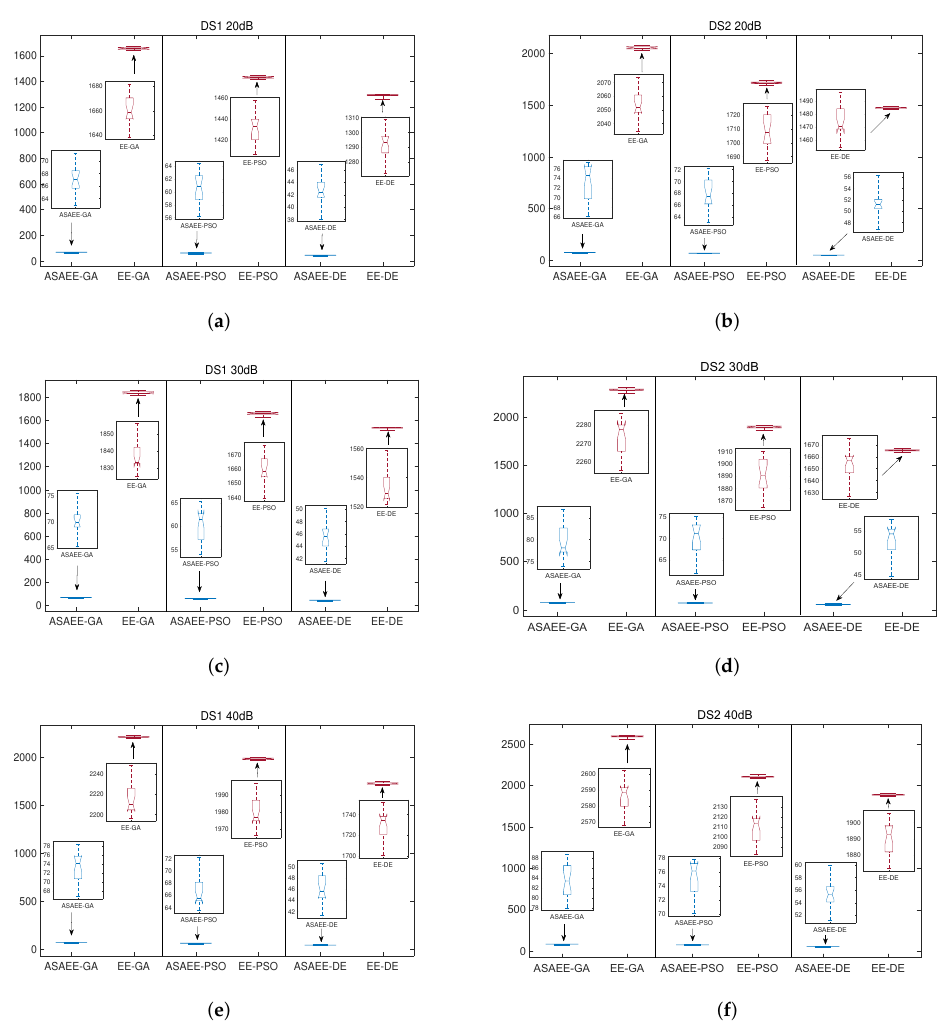
Figure 5. Comparison with and without ASAEE framework on DS1 and DS2 under different